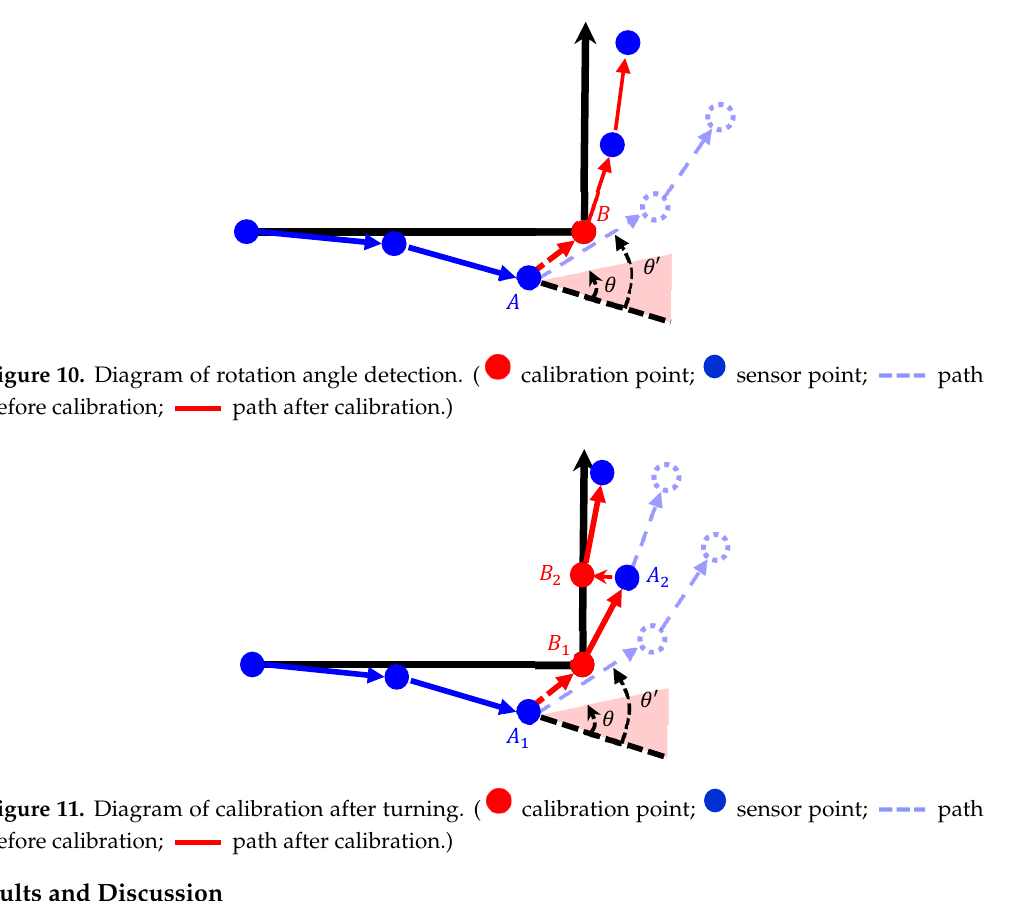
Figure 9. Diagram of azimuth detection. ( calibration point; sensor point; true path; sensor path.) Figure 11. Diagram of calibration after turning. ( calibration point; sensor point; path before calibration; path after calibration.)